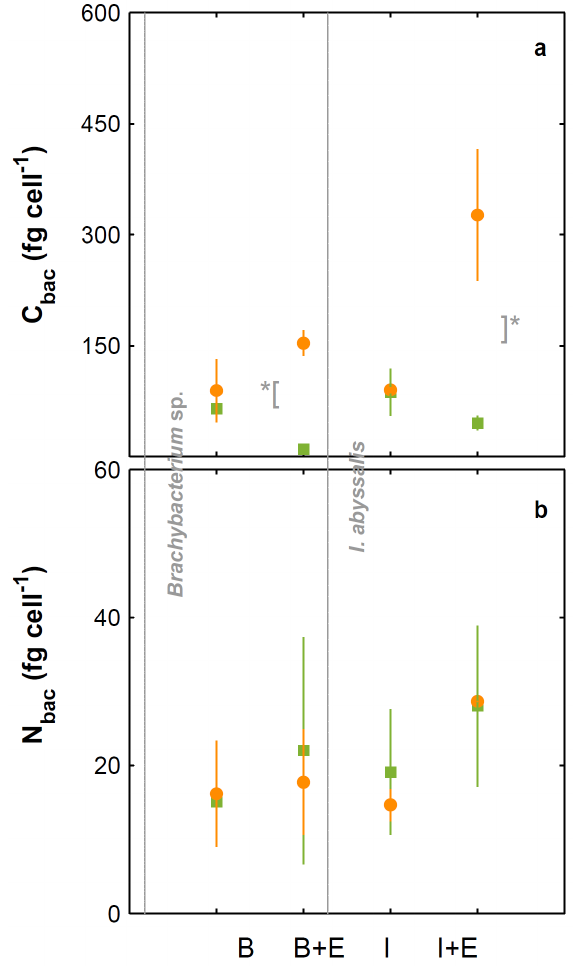
Figure 6. Cellular element quotas (based on total and organic particulate) of Brachybacterium sp. (B) and I. abyssalis (I) monocultures and those bacteria co-cultured with E. huxleyi ( Brachybacterium sp., B + E; I. abissalis , I + E), under 475 (green) and 1056 µatm (orange). Total particulate carbon ( a ) and particulate nitrogen ( b ). * Denotes significant differences.